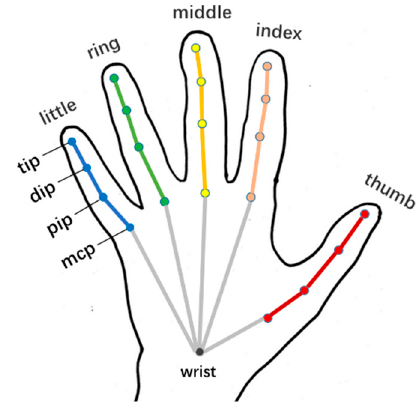
Figure 3. Twenty-one joints of a right-hand skeleton.